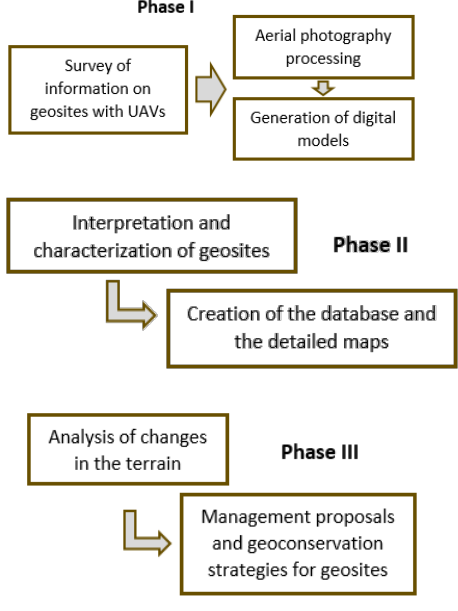
Figure 2. Methodological framework from aerial surveying to the management proposals. In the phase I, the image acquisition of each geosite with UAS were developed. Due to the long time span, we have used different UAS models (eBee standard and